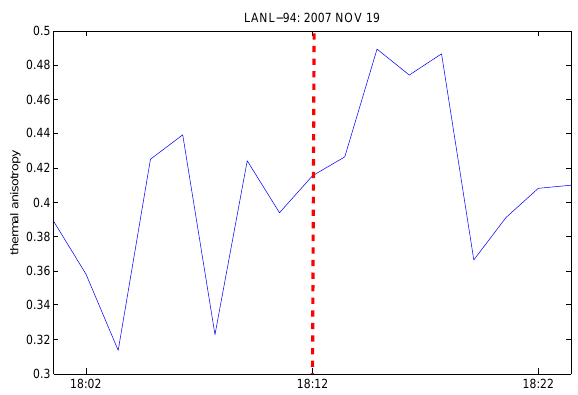
Figure 2. 19 November 2007: LANL-94 observations of the ther- mal anisotropy A = T ⊥ /T k − 1. The red dashed line depicts the time at which the GOES-10 observed the decrease in the total magnetic field.